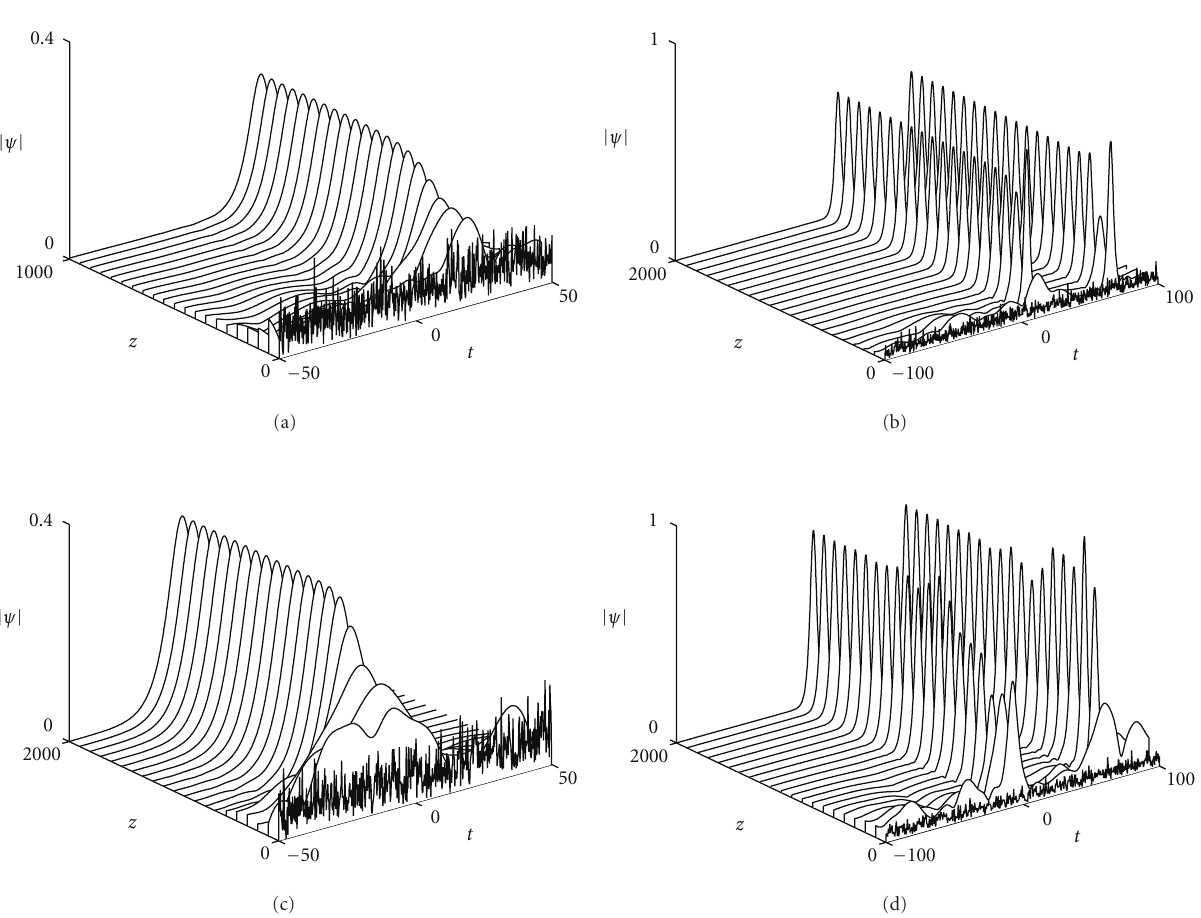
Figure 8: Numerical simulations of the full governing system ((a) and (b)) and the SGLE ((c) and (d)) at di ff erent gain values g 0 in the normal dispersion regime. (a) and (c) Stable single-pulse evolution starting from white noise at g 0 = 1. (b) and (d) The initial white noise evolves into two identical pulses per cavity round trip at g 0 = 3. The rest of the parameters in the simulations are D = − 0 . 4, α 1 = 0 . 1 π , α 2 = 0 . 554 π , α 3 = 0 . 23 π , α p = 0 . 43 π , K = 0 . 1, Γ = 0 . 1, e 0 = 1, and τ = 0 . 2 (from [29], 2011,